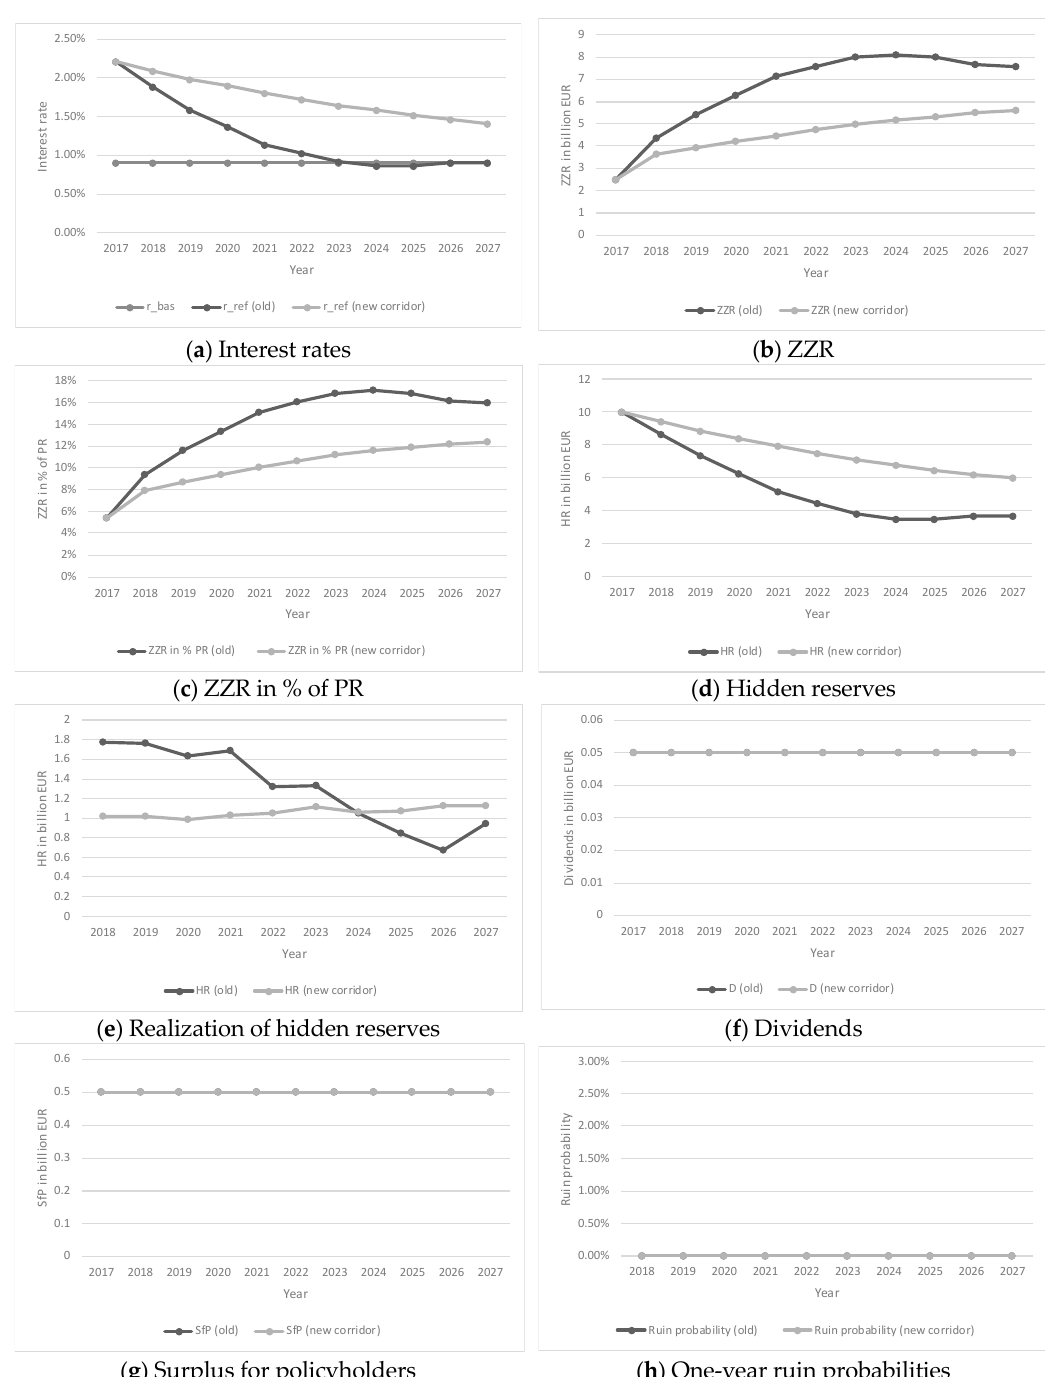
Figure 1. Simulation results in interest rate scenario 1.